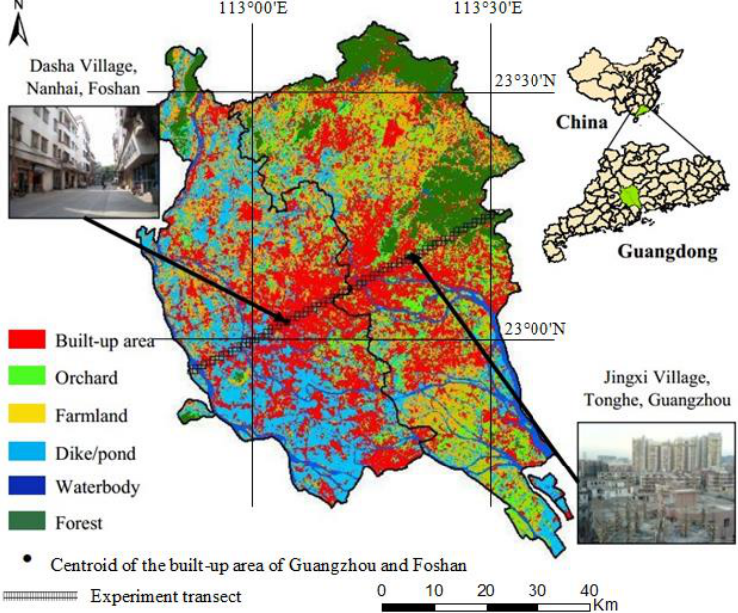
Figure 1. The study area and land cover map of the study area in 2008 and the sample transect crossing two centroids of the built-up area of Guangzhou and Foshan.